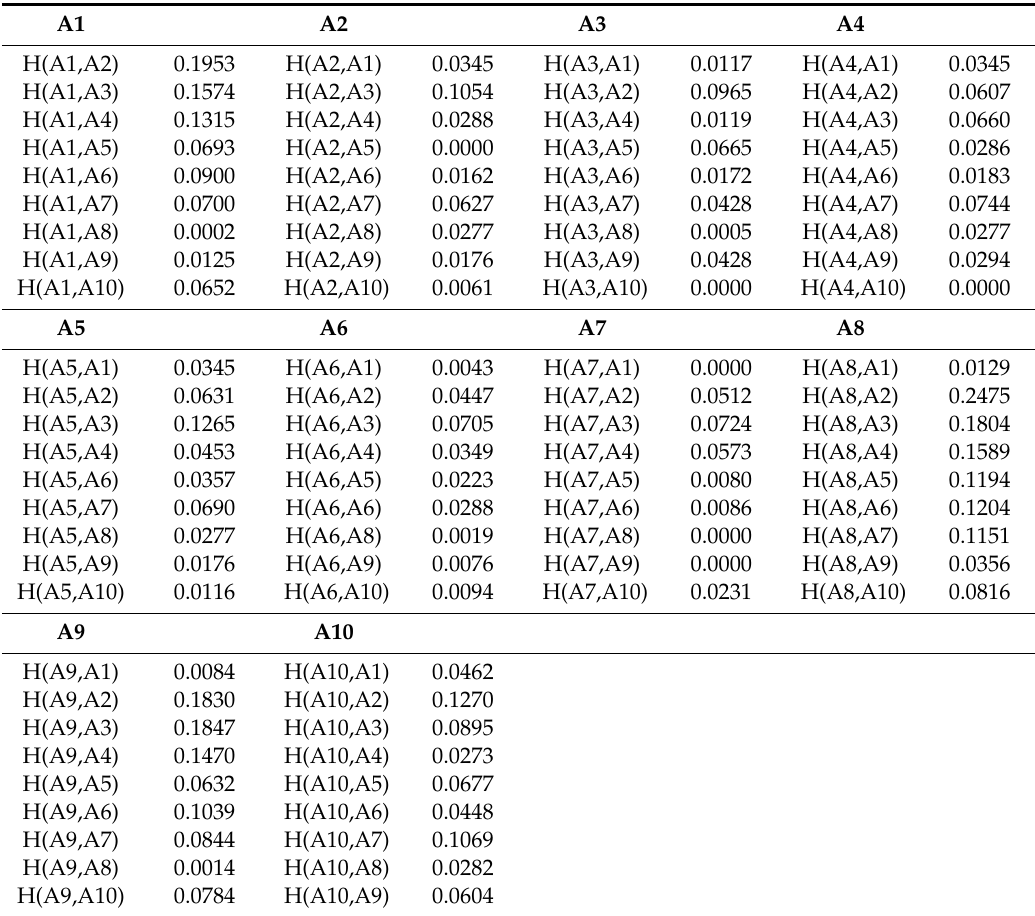
Table 6. Preference index H of cities in 2014.